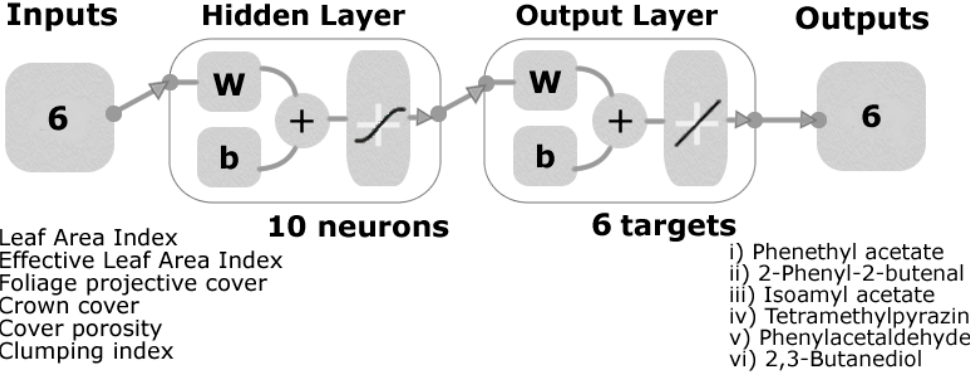
Figure 4. Model diagram showing the two-layer feedforward network with six inputs from the canopy architecture, 10 neurons in the hidden layer with a tan-sigmoid function, and a linear transfer function in the output layer. Six targets/outputs from the volatile compounds were used for the model.